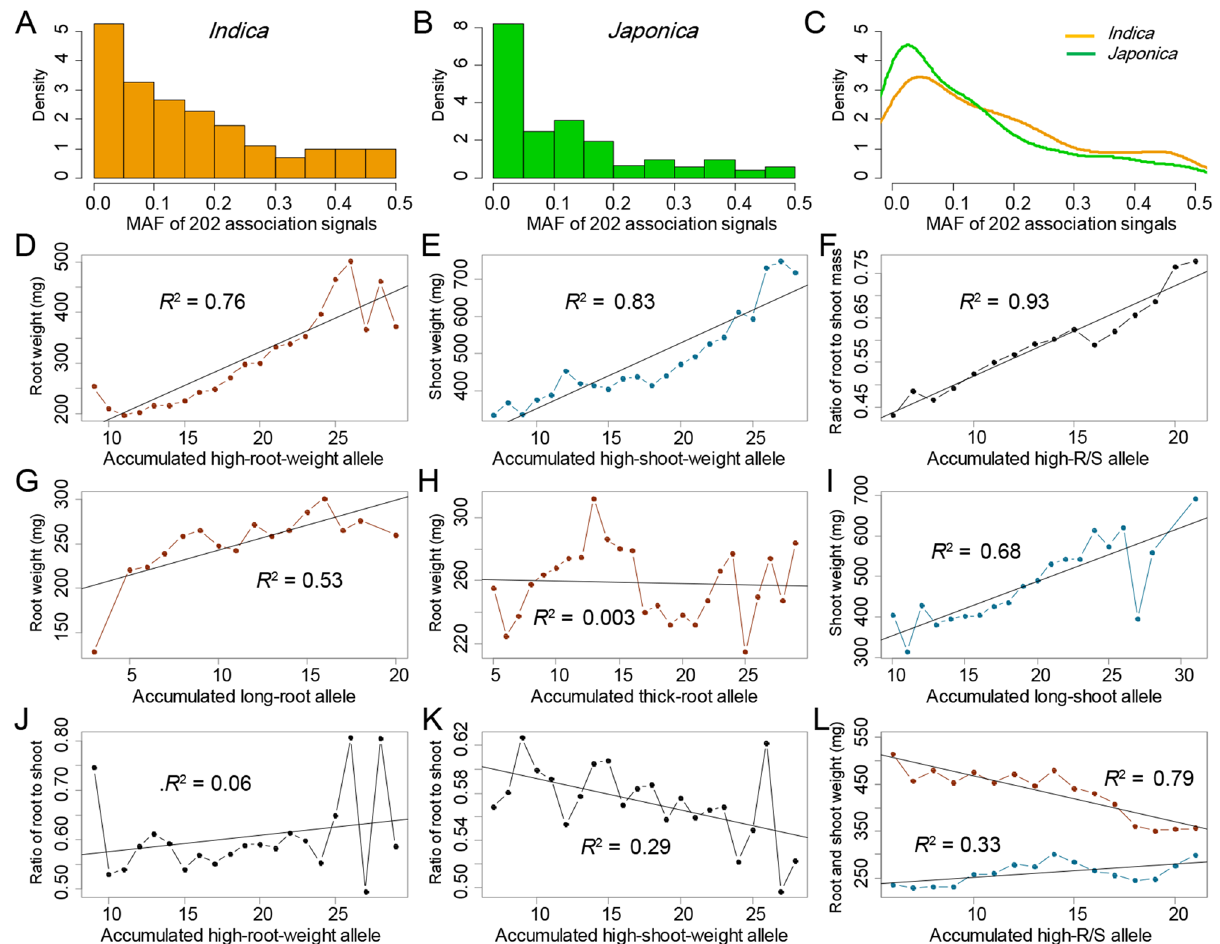
Figure 4. Dissection of genetic basis underlying rice biomass. Characterization of allele frequencies at 202 association signals in ( A ) indica and ( B ) japonica , and ( C ) comparison of them between both rice subpopulations. Plots of the ( D ) root weight, ( E ) shoot weight and ( F ) ratio of root-to-shoot mass against the accumulation of their corresponding to superior alleles. Plots of the ( G , H ) root weight and ( I ) shoot weight against the accumulation of their sub-traits superior alleles. Plots of the ratio of root-to-shoot mass against the accumulation of ( J ) root weight and ( K ) shoot weight superior alleles. ( L ) Plot of ratio of root-to-shoot mass against root weight and shoot